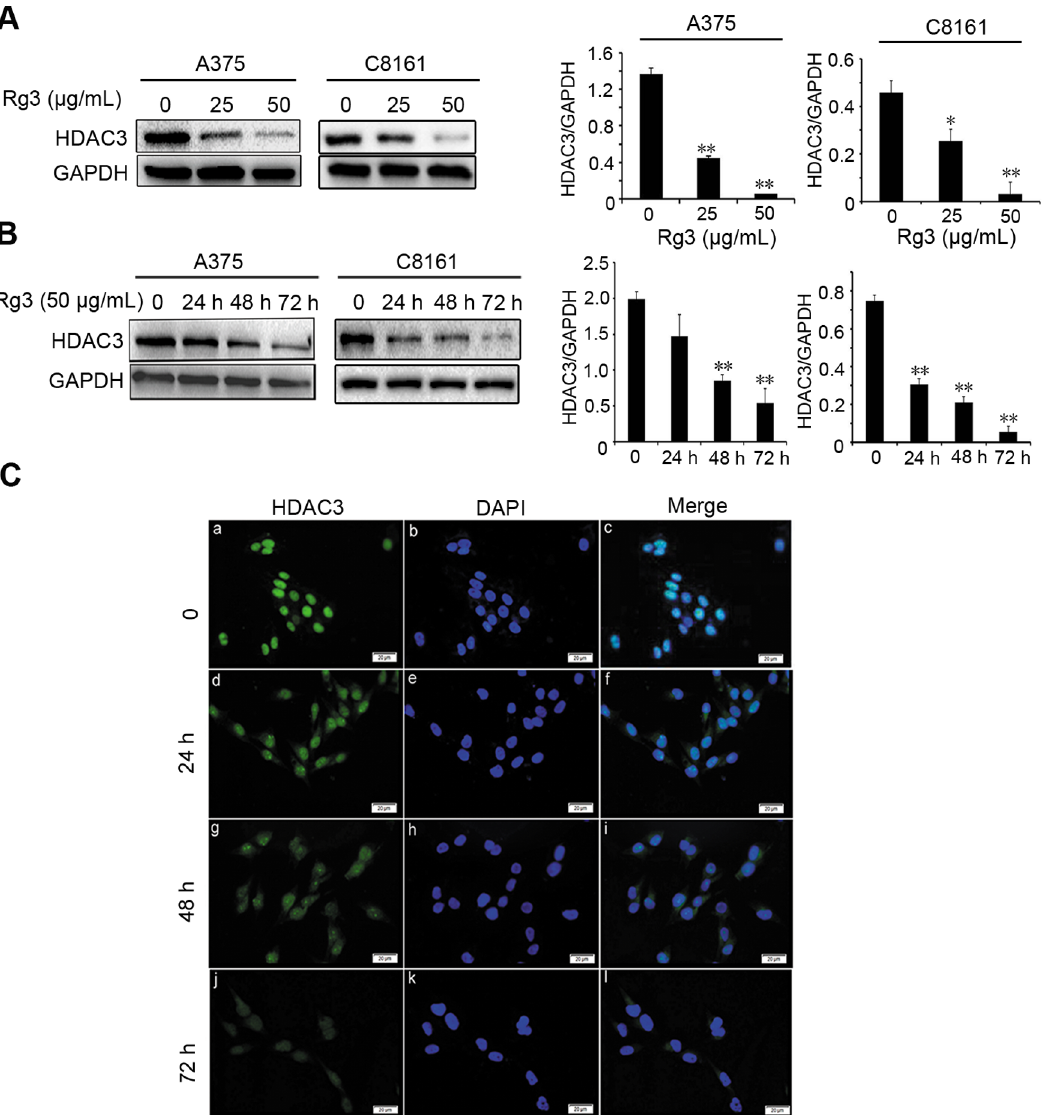
Fig. 3. Rg3 decreases HDAC3 expression. (A) Analysis of HDAC3 level by Western blotting in A375 and C8161 cells after cells treated with Rg3 (0, 25, 50 m g/mL) for 72 h. (B) HDAC3 expression level in cells treated with Rg3 (50 m g/mL) for 0, 24, 48 or 72 h. GAPDH was used as an internal control. The statistical analyses for Western blotting results were shown (*, p , 0.05; **, p , 0.01). (C) Immunofluorescent staining of HDAC3 in A375 cells after Rg3 (50 m g/mL) treatment for 0, 24, 48 or 72 h. DAPI used as a nuclear staining. Bar 5 20 m m (magnification, 6 400). Data were presented as the mean ¡ S.D. of three independent